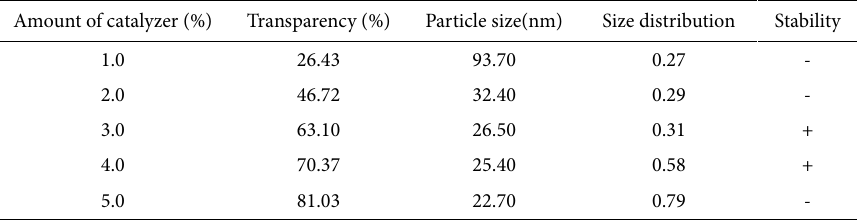
Table.2 Effect of catalyzer on the Table. 2. Effect of catalyzer on the microemulsion